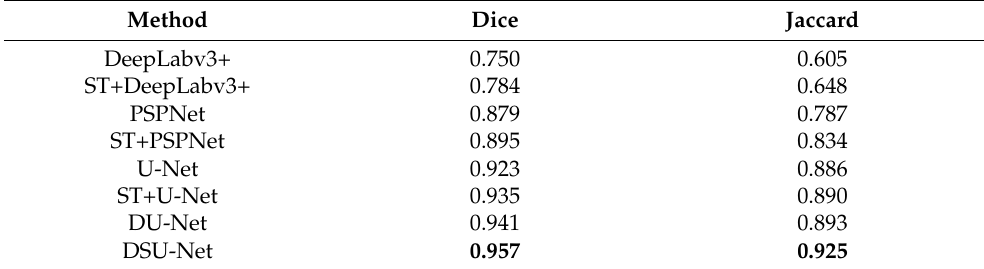
Table 2. Experimental results of prostate segmentation in TRUS